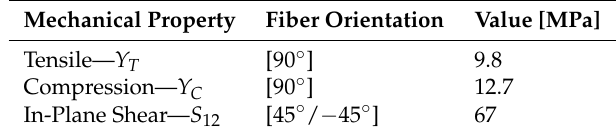
Table 4. Experimental data for 3D-printed continuous glass-fiber reinforced thermoplastic lamina